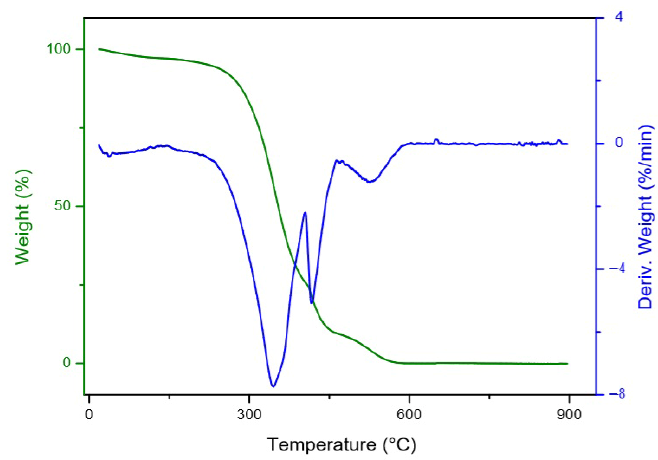
Figure 3. Thermal decomposition of canjiqueira seed oil.